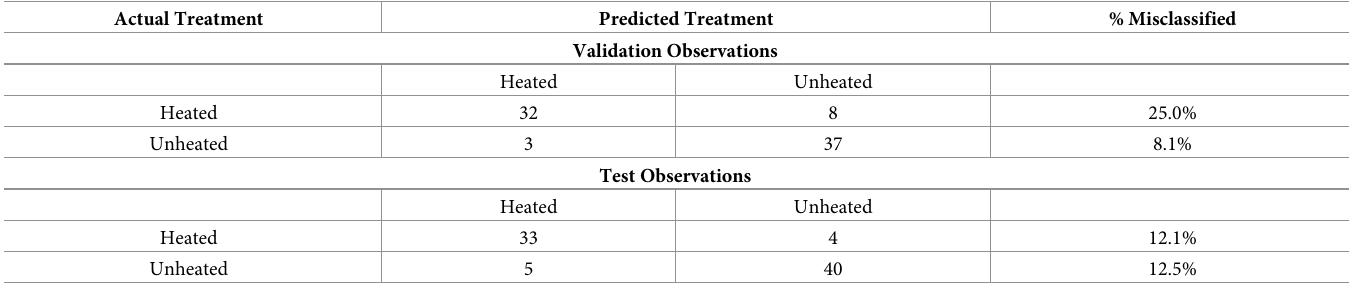
regression model: 13.9%. As illustrated by the observation-level misclassification rates and the specimen-level misclassification rates in the two tables below (Tables 8 and 9), this model has a greater false positive issue than either of the k- NN models. Examination of the specimen-level validation set found that the three misclassified flakes (unheated predicted to be heated) all derive from the same silcrete nodule (6B) collected from source E3. Furthermore, the two misclassified specimens in the training set also derive from nodule 6B. This suggests that a single piece of silcrete with anomalous properties relative to other nodules from that source underlies all of the false positive prediction error in this model. The atypical response of E3.6B to heating was noted earlier. Interestingly, in model A, which Table 10. k-NN model C observation-level prediction